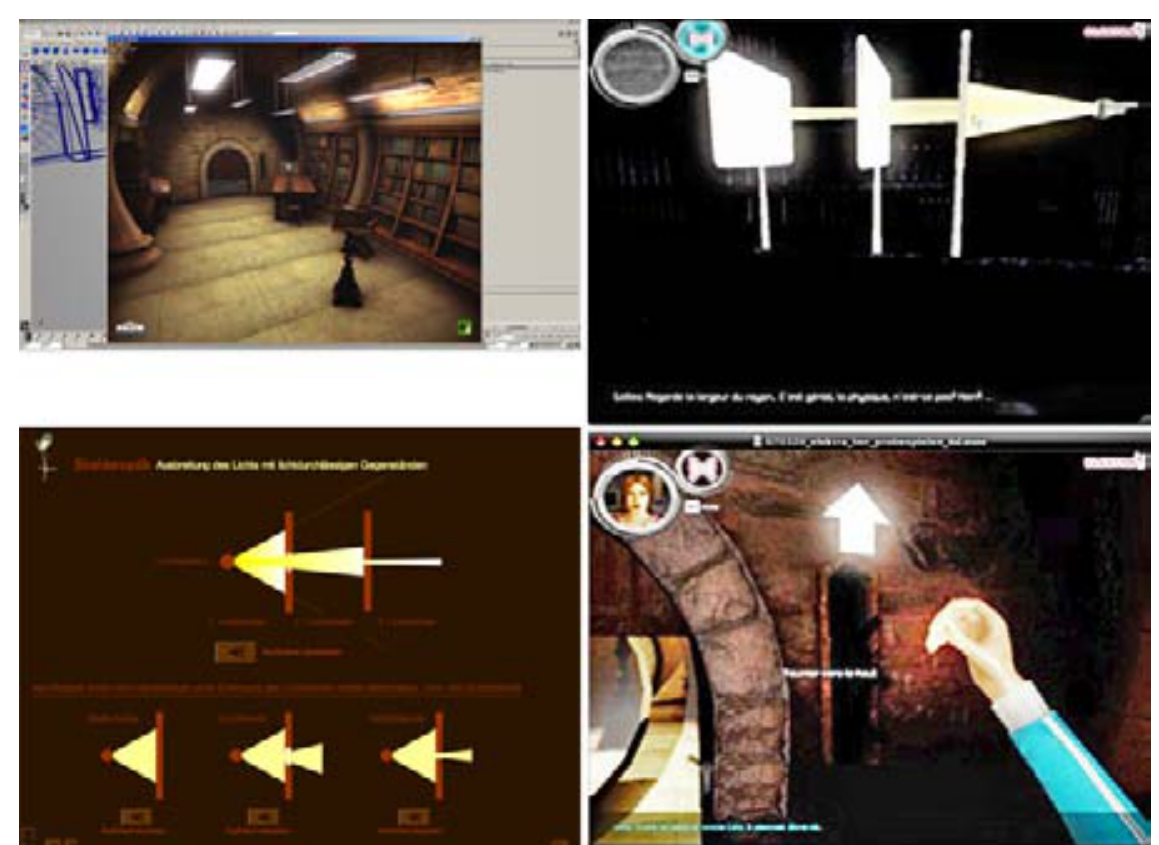
Figure 2. Design of Elektra with extrinsic support in the form of a hyperlinked textbook. In contrast, the third design condition (G_IS), featuring intrinsic support, provides dynam- ically embedded support whenever necessary. The system offers support via a pedagogical agent that gives simple hints to encourage learners to keep trying if they have made an error. If a learner repeatedly fails to solve a given learning task, the system provides com- ments and explanations that contain the correct answer (see Figure